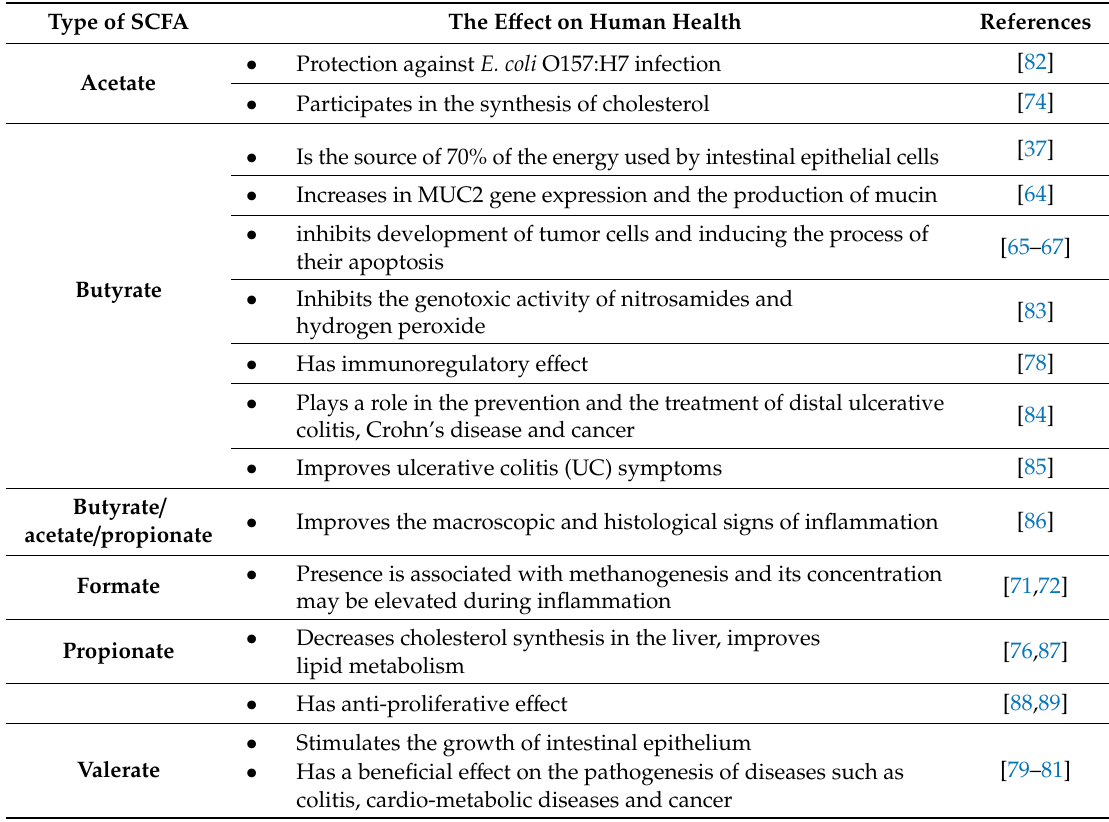
Table 4. Examples of trials regarding the e ff ect of SCFAs on human health. Type of